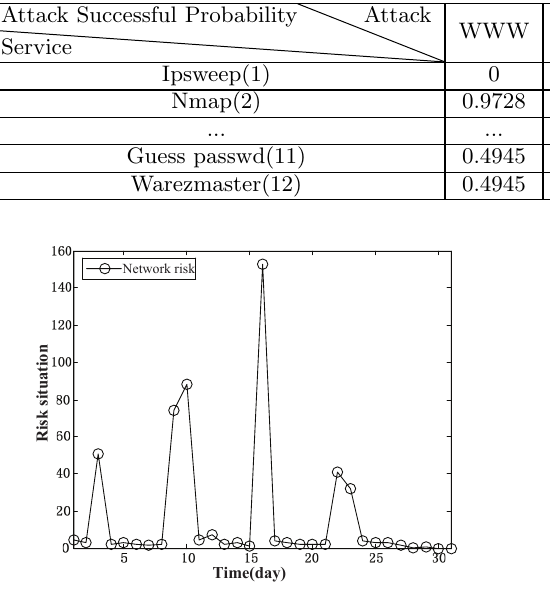
Table 4: Attack Successful Probability